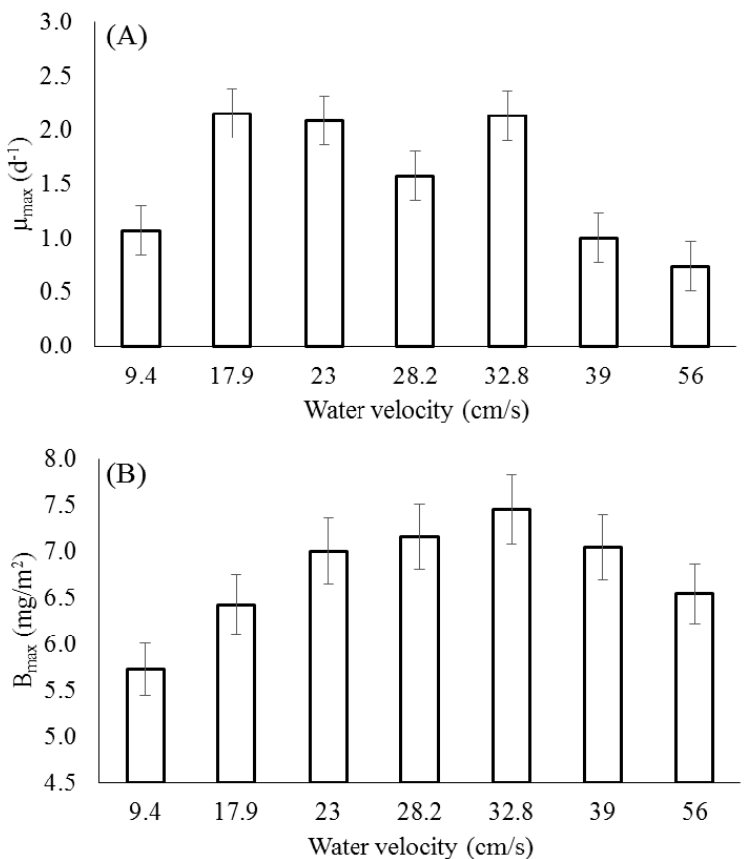
Figure 3. Effect of water velocity on ( A ) μ max and ( B ) B max of Chl ‐ a . Vertical bars represent standard deviation of three replicate determinations.